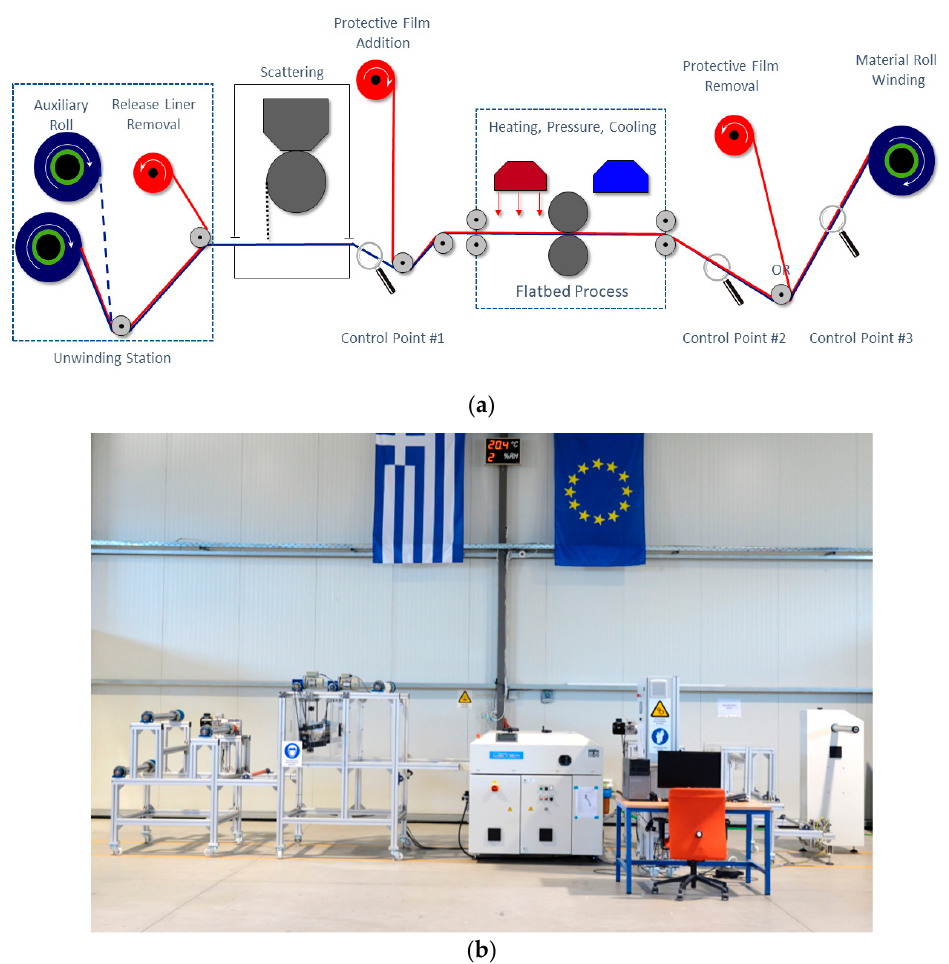
Figure 1. ( a ) Schematic and ( b ) Picture of the Adamant Composites™ roll-to-roll (R2R) pilot line for the production of FXply™ functionalized prepregs. Table 1. Specifications of the R2R pilot line for prepreg